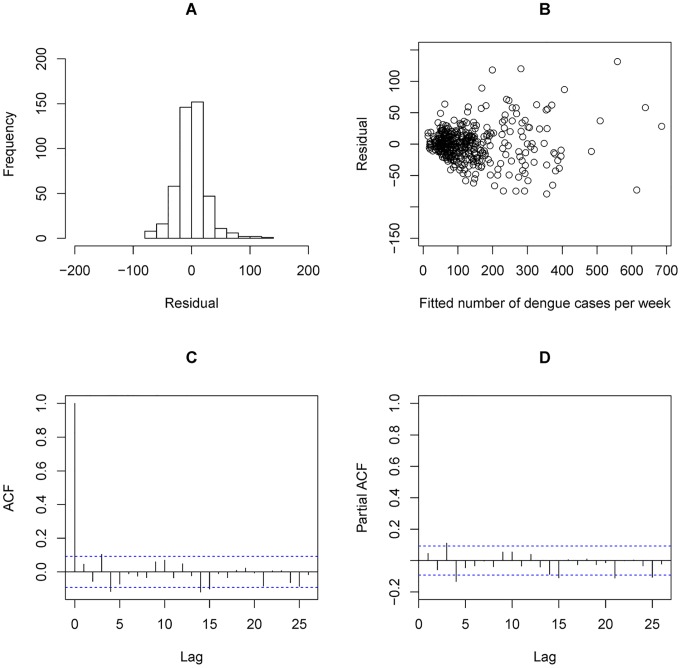
Residual analysis for DLNM-AH model.A: Residual histogram; B: Residual v.s. Number of dengue cases per week; C: Residual autocorrelation function; D: Residual partial autocorrelation function.